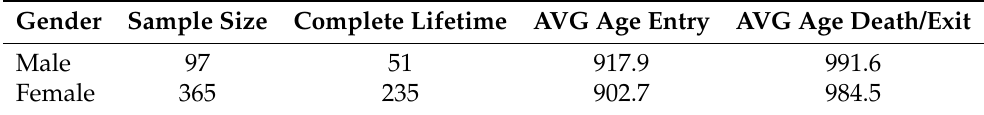
Table 2. Basic statistics of the Channing House